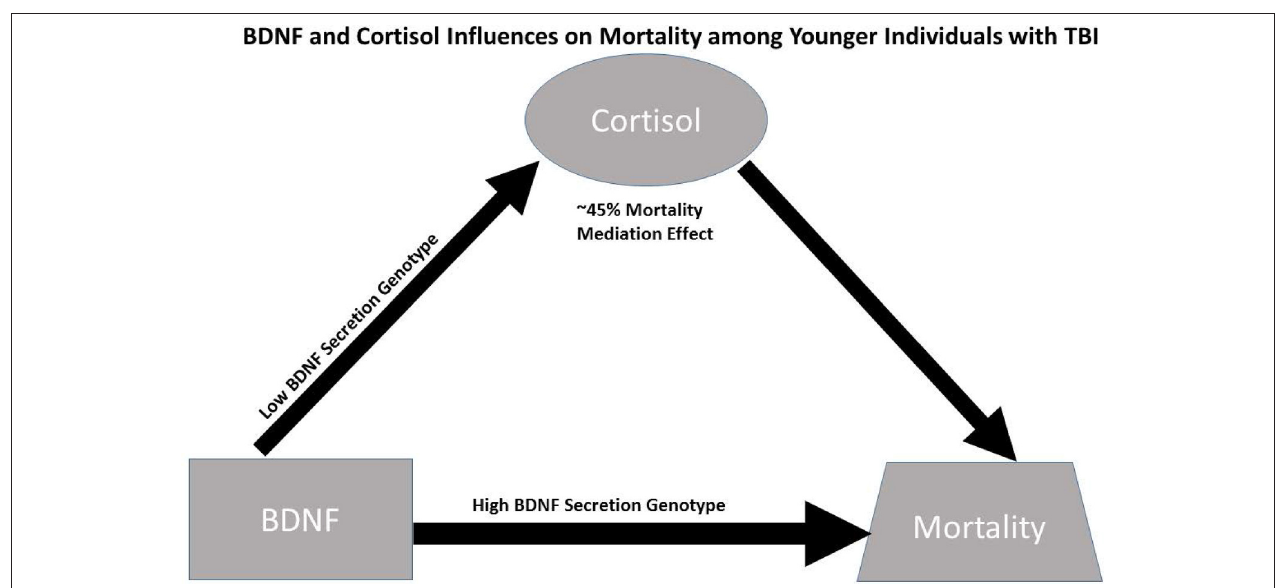
FIGURE 6 | Conceptual figure capturing biomarker relationships among younger individuals ( ≤ 48 years. Old, N = 90): (1) cortisol has a significant regulatory (mediating) effect on BDNF’s influence on mortality, accounting for ∼ 45% of BDNF’s mortality effects; (2) the association between BDNF above/below the 75th percentile and high cortisol TRAJ is only significant among individuals with low BDNF secretion genotypes; and (3) the direct association between BDNF above/below the 75th percentile and mortality risk is stronger among individuals with the high BDNF secretion genotype (GRS = 0) compared to the low secretion genotypes. Taken together, the data support a conceptual model for younger individuals with TBI wherein high BDNF levels among those with high BDNF secretion phenotypes directly increases mortality risk, while mortality risk for those with high BDNF levels paired with low BDNF secretion genotypes is regulated (mediated) by